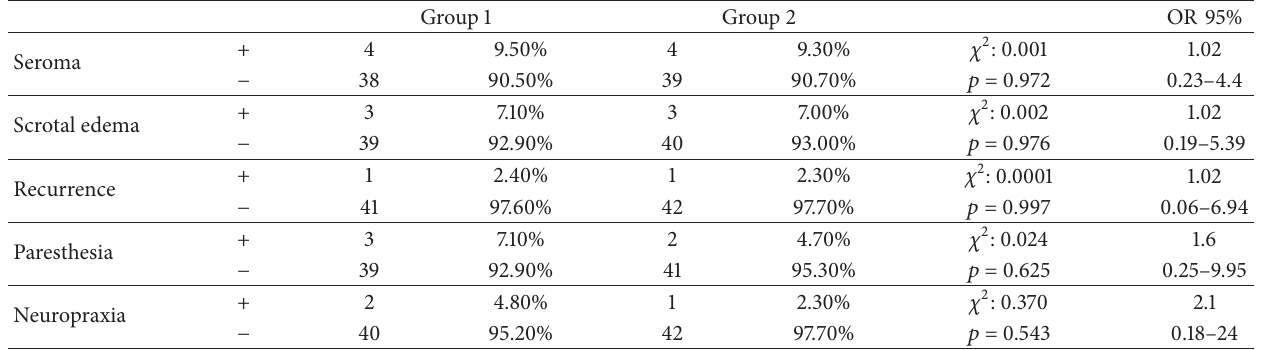
Table 4: Comparison of seroma, scrotal edema, recurrence, paresthesia, and neuropraxia between the